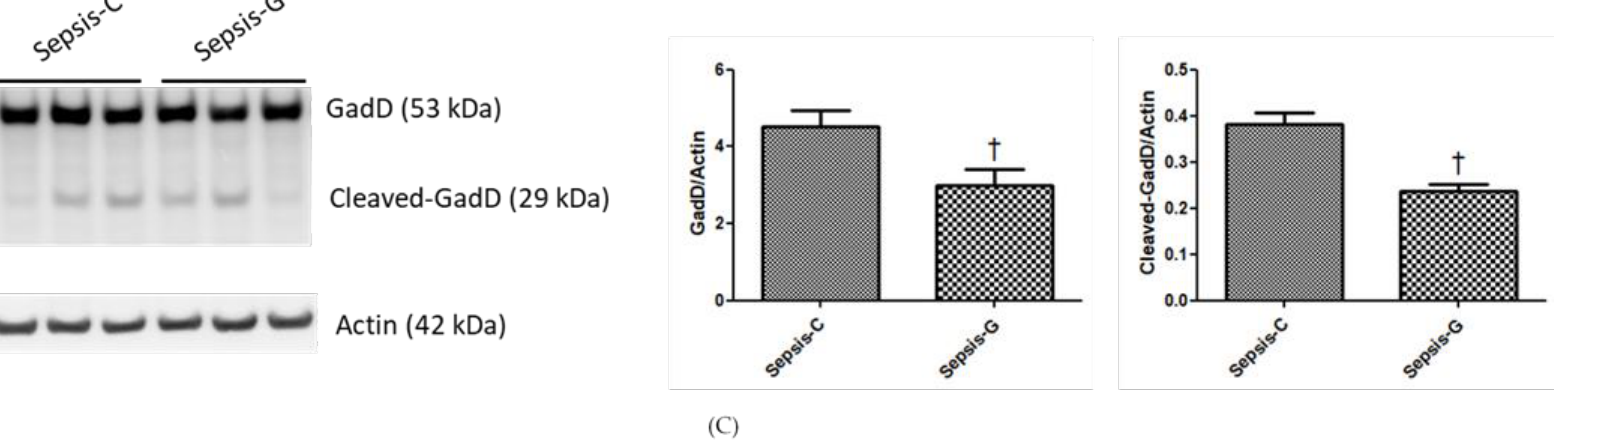
Figure 4. Protein levels of ( A ) pro- and active caspase-1, ( B ) pro- and active caspase-11, and ( C ) gasdermin D (GadD) and cleaved GadD in liver tissues. Whole-tissue lysates were analyzed by immunoblotting, and β -actin was used as a loading control. Densitometric analysis of the blot corrected by the protein loading control. Sham: control group with sham operation; Sepsis-C: control group with cecal ligation and puncture (CLP); Sepsis-G: glutamine (GLN) group with a CLP operation. Results of the densitometric analysis are shown as the mean ± standard error of the mean (SEM). Di ff erences among the sham, Sepsis-C, and Sepsis-G groups were analyzed by a one-way ANOVA with the Bonferroni post-hoc test. † Significantly di ff ers from the Sepsis-C group ( p < 0.05).